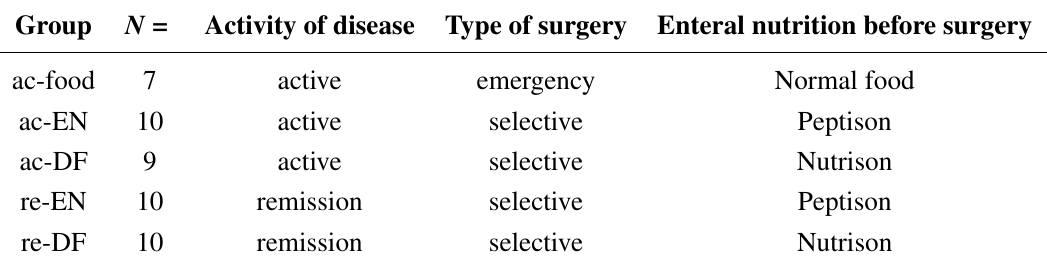
Table 1. Groups of the 46 Crohn’s disease